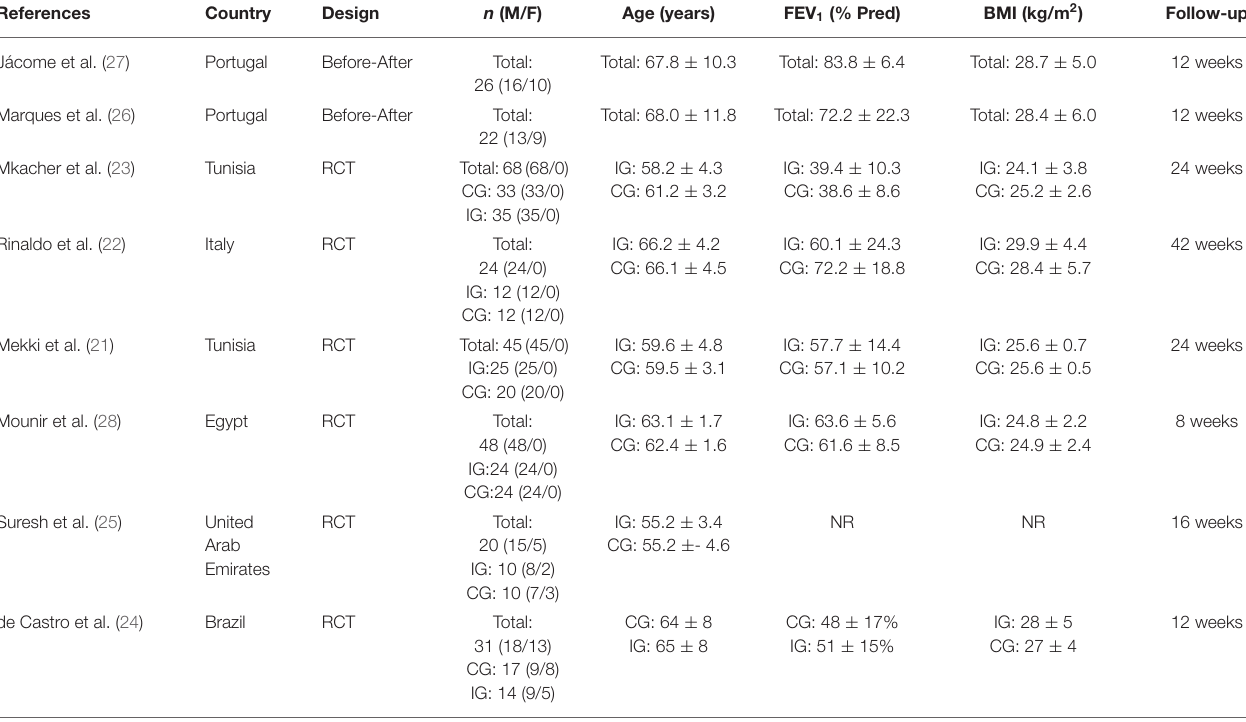
TABLE 1 | Characteristics of the